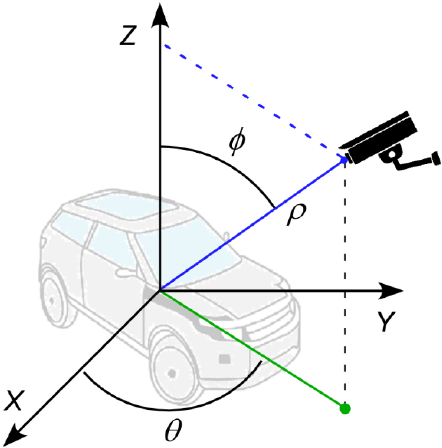
Figure 4 . Camera view of a vehicle in the spherical coordinate system . Figure 4. Camera view of a vehicle in the spherical coordinate